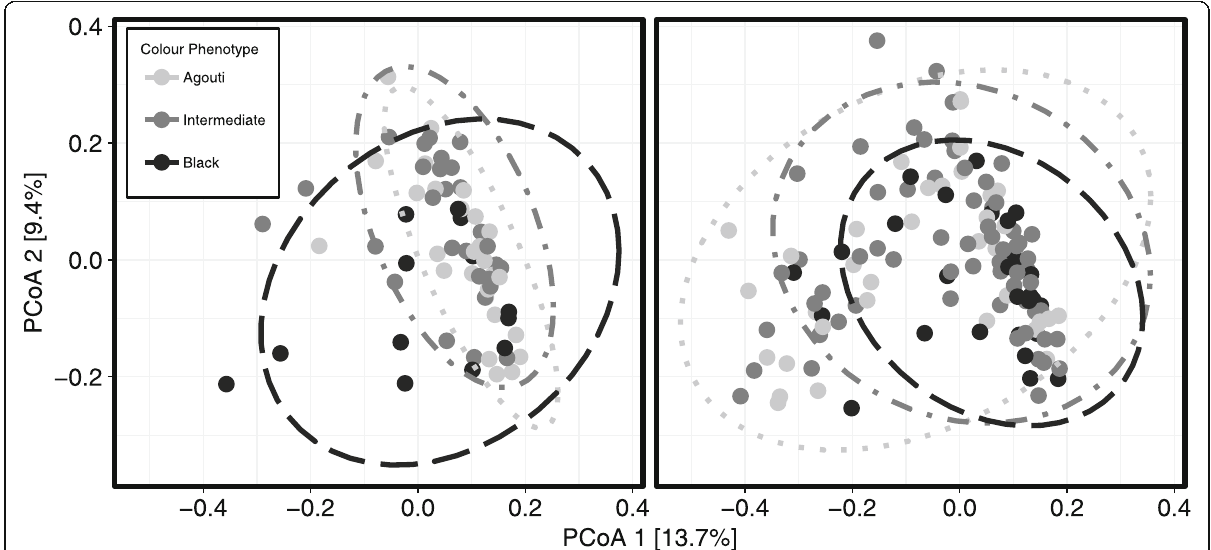
Fig. 4 Weighted UniFrac principal coordinate analysis ordination of the eastern grey squirrel microbiome separated by environment and coloured and shaped by phenotype with 95% confidence ellipses. Agouti squirrels display greater beta-dispersion ( p = 0.05) within cities (right panel) than in rural environments (left